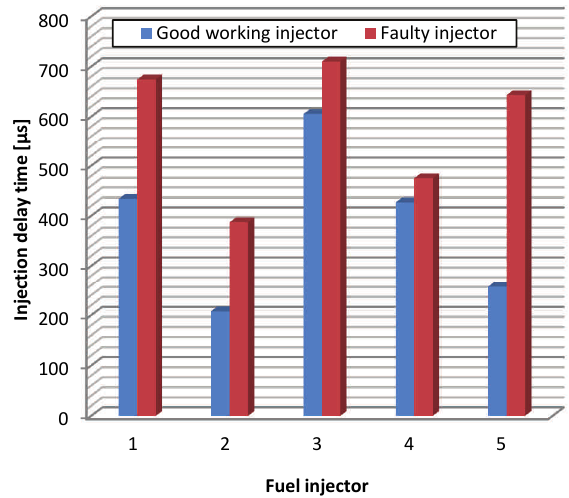
Fig. 17. Comparison of RSP parameter between faultless and faulty fuel injectors 1 – electromagnetic Bosch fuel injector, 2 – piezoelectric Bosch Table 10. Test results of faulty piezoelectric Continental fuel injector fuel injector, 3 – electromagnetic Denso fuel injector, 4 – electromagnetic research Delphi fuel injector, 5 – piezoelectric Continental fuel injector Piezoelectric Continental fuel injector no. A2C59511603 Tables 1–10 present the results of tests of the number eRLC